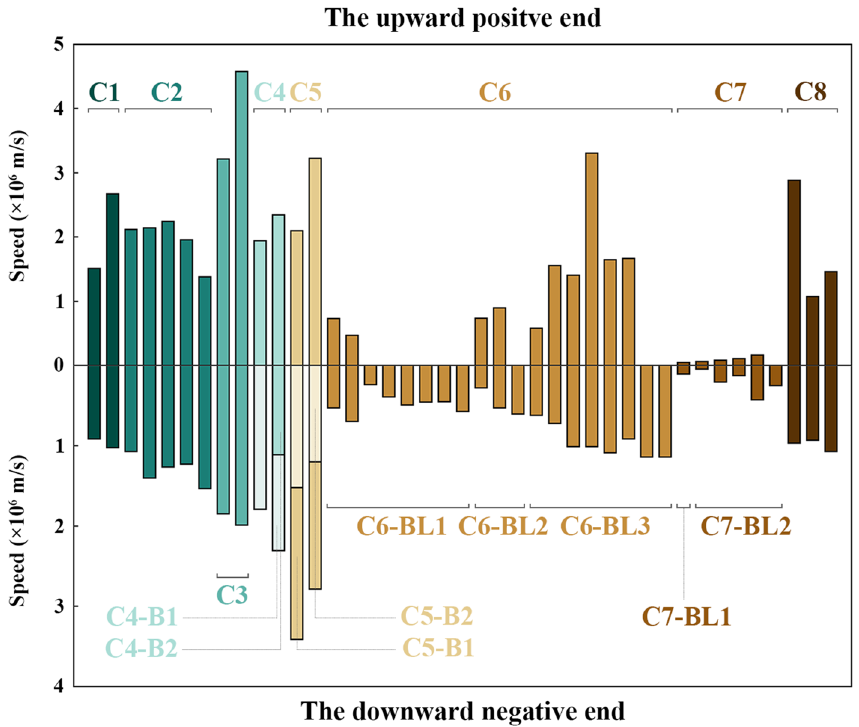
Figure 2. The propagation speed of two ends of BL development in eight cases. C1 represents Case 1, C2 represents Case 2, and so on. C4-B1, C4-B2, and C5-B1, C5-B2 represent the two branches of the downward negative end in Case 4 and Case 5. C6-BL1 to BL3 represent the three BL development in Case 6. C7-BL1 to BL2 represent the two BL development in Case